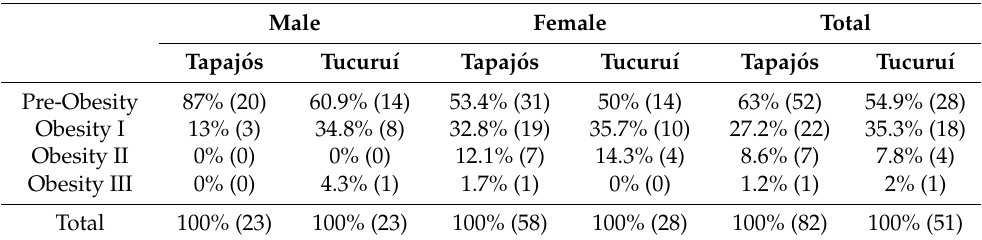
Table 4. The prevalence (and number of participants) of nutritional status of the pre-obesity/obesity group according to the body mass index (BMI) of the riverine populations from the Tucuru í and Tapaj ó s